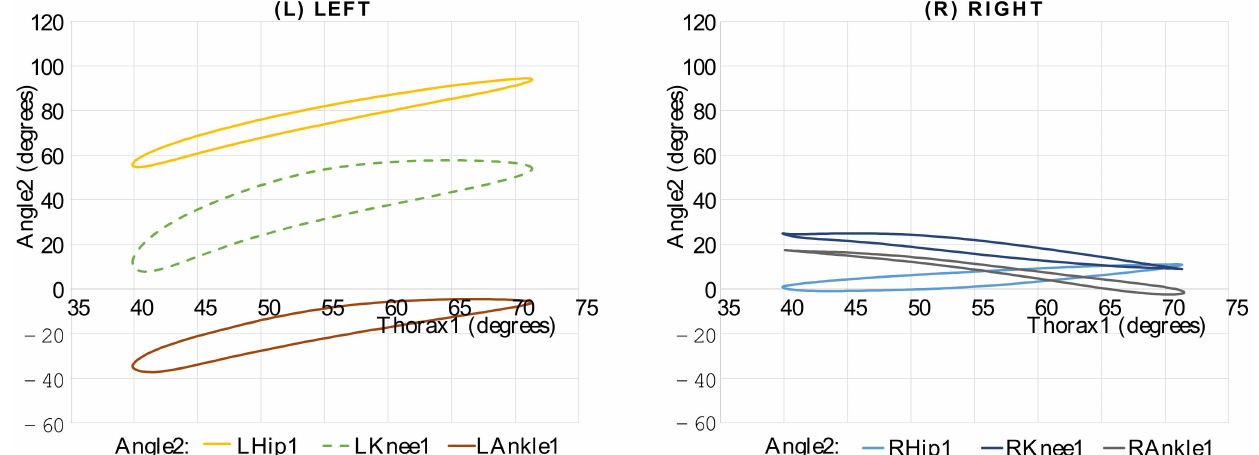
Figure 10. Angle–Angle plots which illustrate the relationship between movements in the lower body with that of the thorax. See also supplementary information for other plots. Table 4. The range of motion values, θ ROM , of the hip, knee and ankle angles measured for the Venetian style rowing technique, in degrees, ± 1 s.d., for the individual rowers 1–4, their mean, and its equivalent mean value for standard ergometer rowing, with p -value for these two means reported in parentheses.